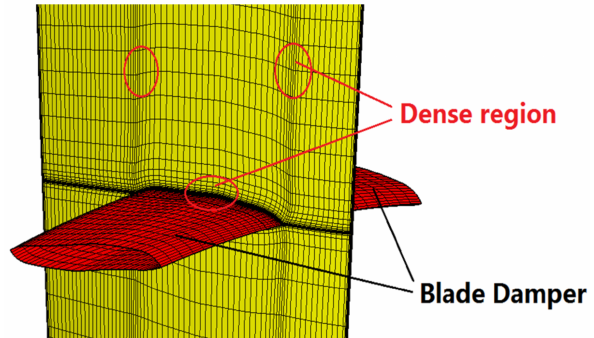
Figure 2. Schematic diagram of grid details for R1 and R5.